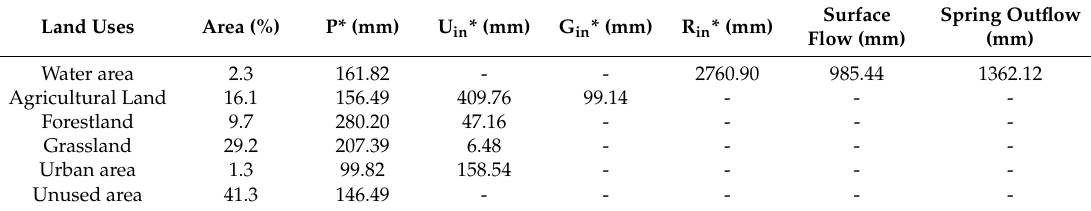
Figure 7. Monthly streamflow comparison between the simulations and observations in the calibration and validation periods of the middle reach at Zhengyixia station. Table 6. Inflows of the six land use types of the middle reach of Heihe River.